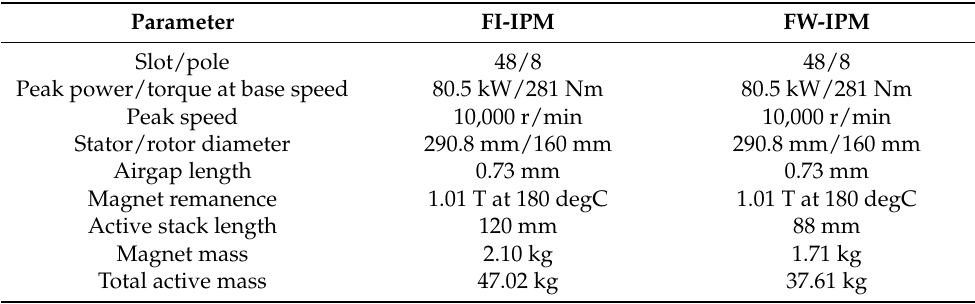
Table 2. Key design parameters and performance metrics of the FI-IPM and FW-IPM